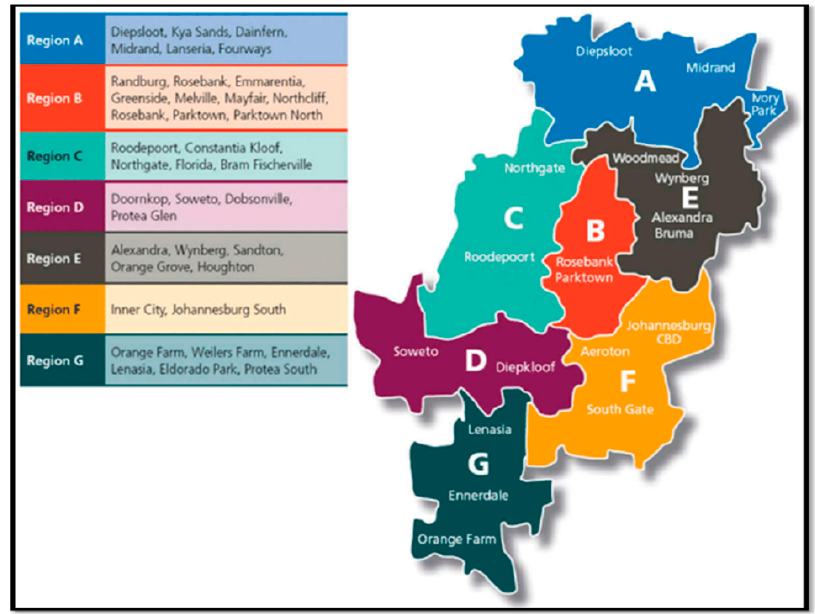
Figure 1. Location map (Region F inner city) (CoJ, 2021).